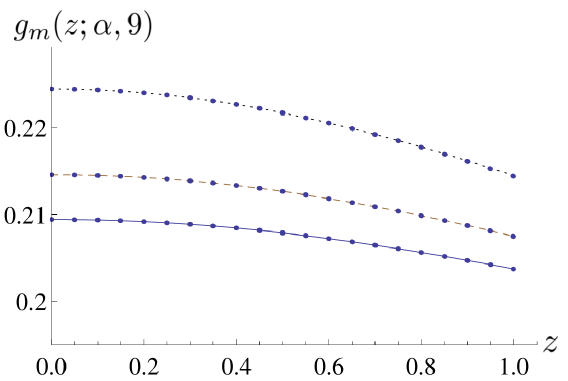
( z ; α ,9 ) , mean of the 18 th and 20 th order in 1 /α of g ( z ; α ) , Figure 1: Dimensionless function g m as a function of the dimensionless variable z , at dimensionless parameters α = 2.5 (solid, blue), α = 2.3 (dashed, brown) and α = 2 (dotted, black) from bottom to top, compared to the corresponding numerically exact solutions (blue dots). Only a few numerical values are shown to improve the visibility, and numerical error is within the size of the